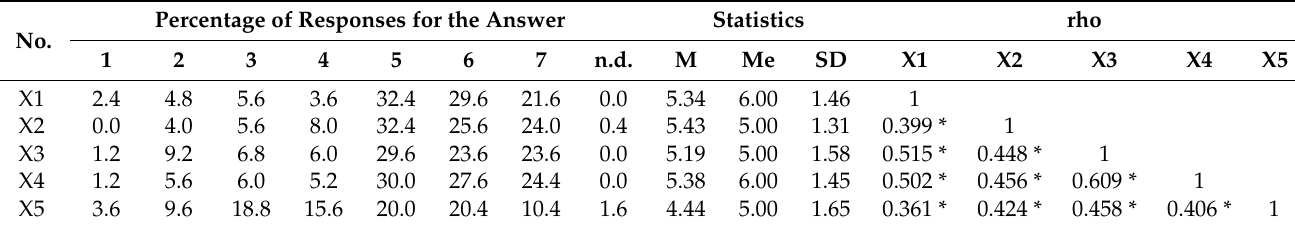
Table 8. Benefits of the intelligent transport systems.